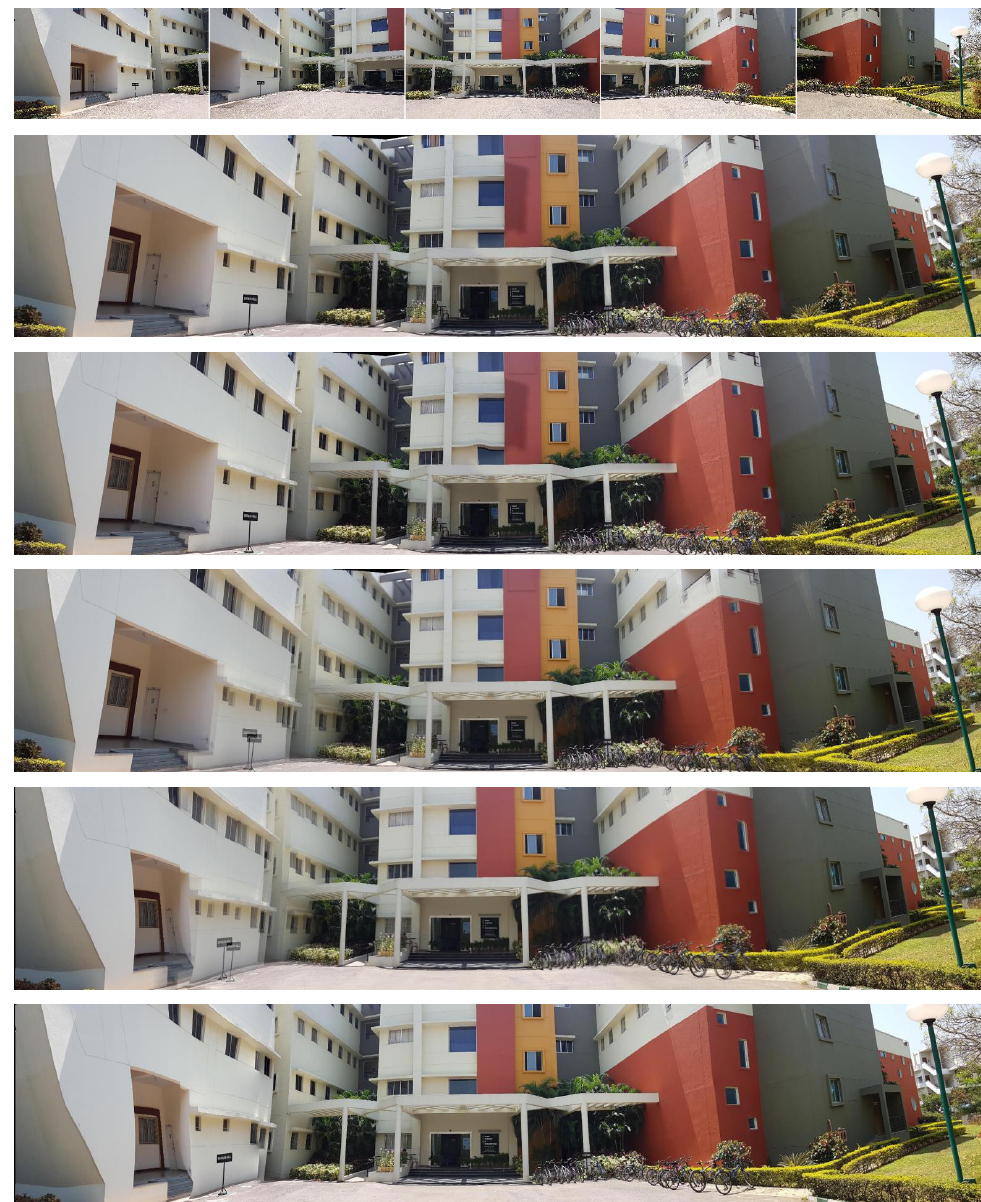
Figure 2. Sample constituent (top row) and stitched images from set #3 of ISIQA database with various types of